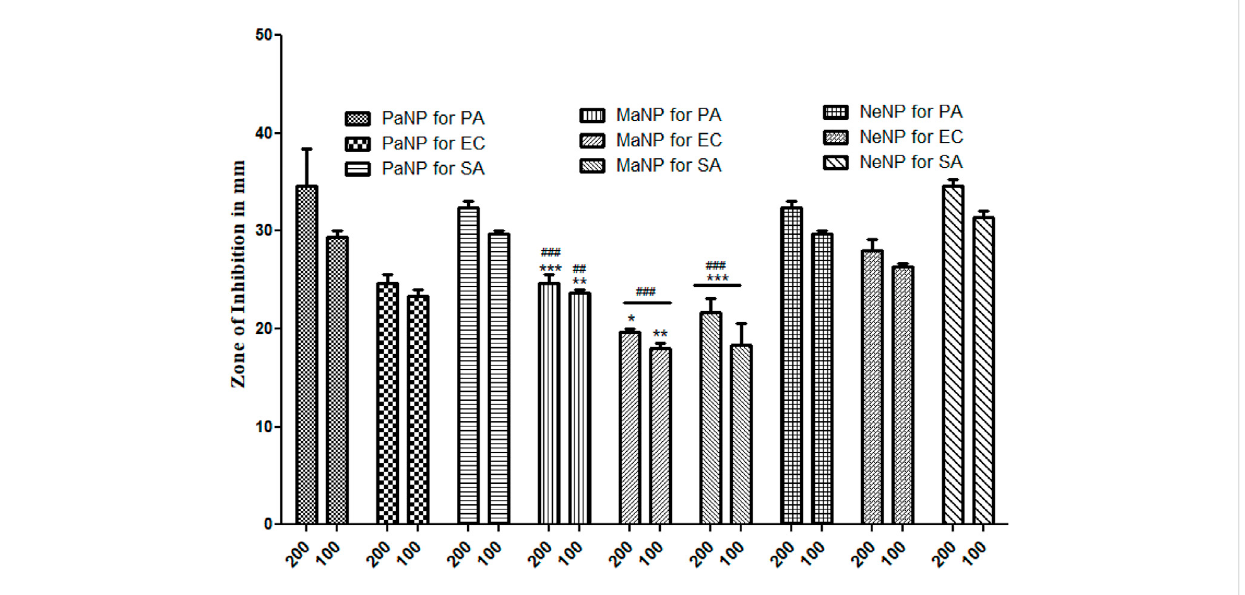
FIGURE 13 Antimicrobial activity of naturally synthesized NPs from neem, papaya, and mango which are named NeNP, PaNP, and MaNP, respectively against 3pathogenic strainsbyGeldiffusionmethod. Pseudomonasaeruginosa (PA) Escherichiacoli (EC)andGram-positive Staphylococcusaureus (SA)(Values represent the Mean S.E. for n = 4 replicates. [***] p < 0.001; [**] p < 0.01 and [*] p < 0.05 compared PaNP with two concentration (200 and 100) all other pathogenic strains used in the study. [ ### ] p < 0.001 and [ ## ] p < 0.01 compared NeNP with two concentration (200 and 100) all other pathogenic strains used in the